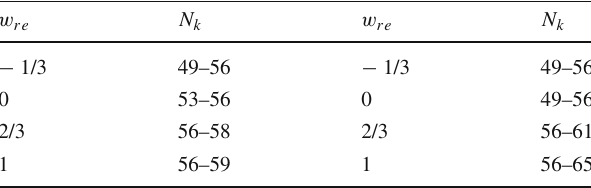
Table 7 Summary of the allowed range for the number of e -folds for each EoS parameter w re when the dimensionless parameter α is fixed to α = 0 . 0135. The left and right tables corresponds to a 5-dimensional Planck mass of M 5 = 10 5 TeV and M 5 = 10 12 TeV respectively